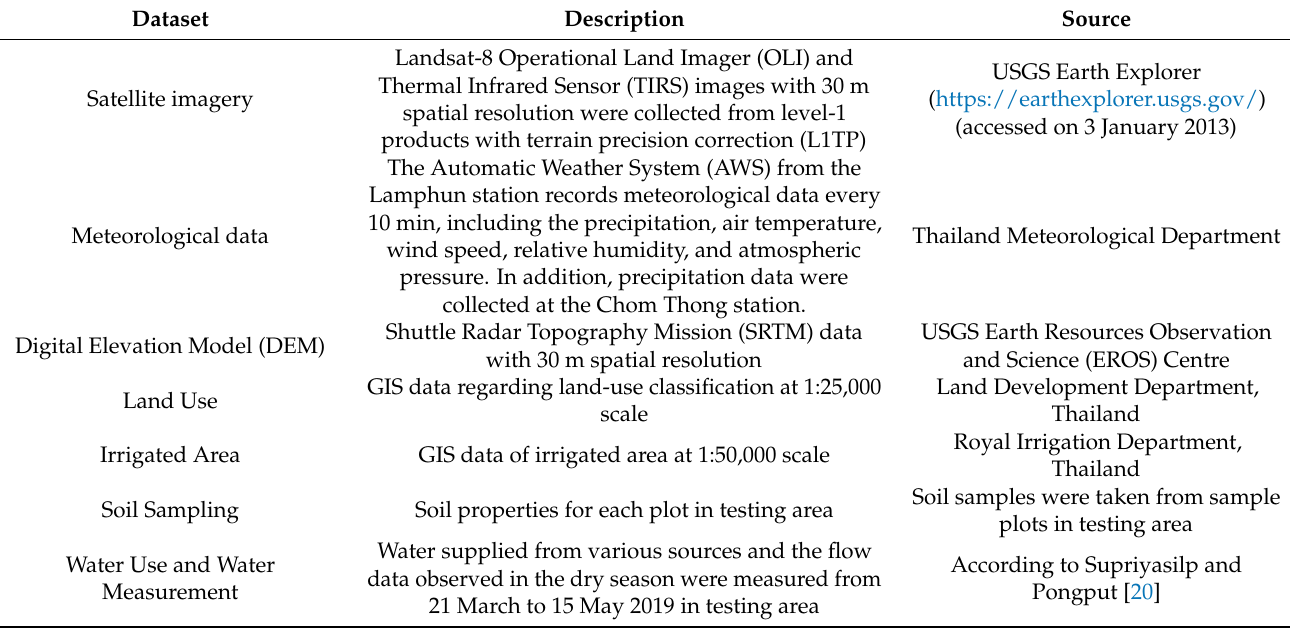
Table 3. Datasets used in this